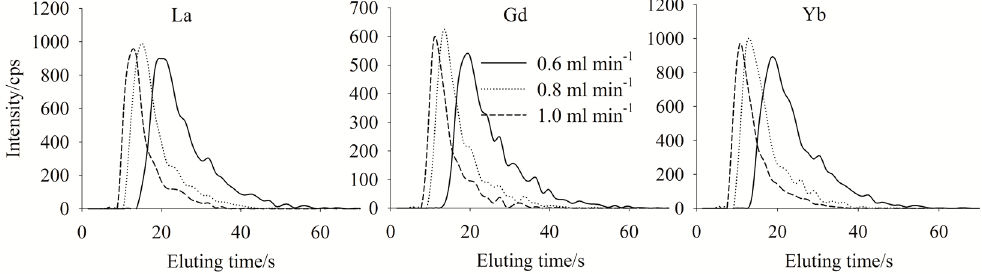
Figure 3. Elution profiles for Y when eluted with 0.8 mol L − 1 HNO 3 at different flow rates; test sample salinity = 33.